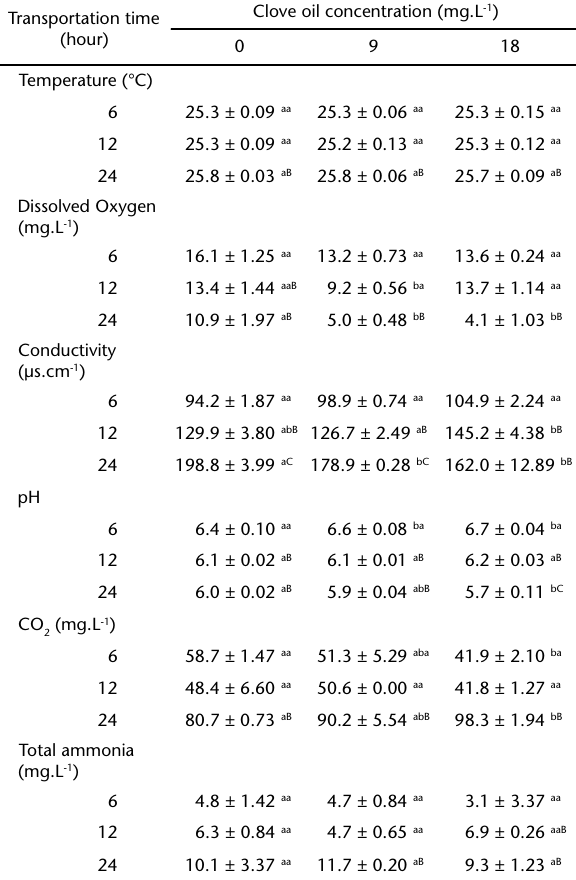
Table II. Water quality after transportation of O. niloticus juveniles for different times and at different clove oil concentrations. Data were analyzed by Two-way ANOVA and Tukey test (p < 0.05). Lower case letters indicate statistical difference of the different treatments at one same transportation time. Upper case letters indicate statistical difference of different transportation times for one same